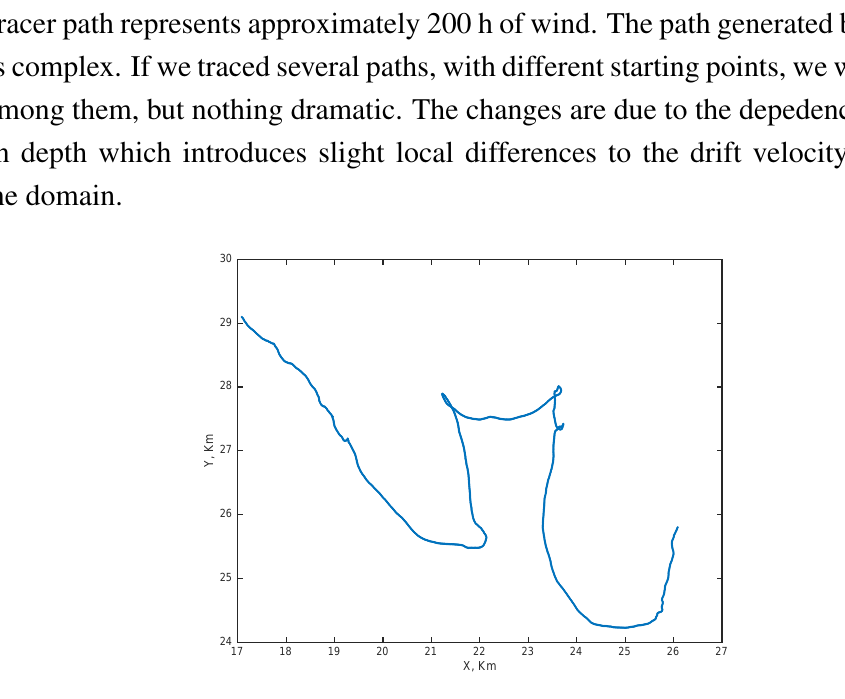
Figure 12. Lagrangian path of an ideal tracer induced by the Stokes drift from the wind data. The path would be identical in all cases in this section in which we are activate the wave-induced advection. The path direction in time is to the